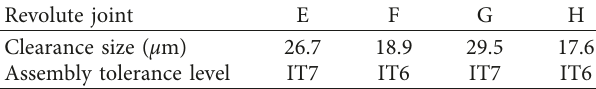
Table 3: The clearance size after optimization.